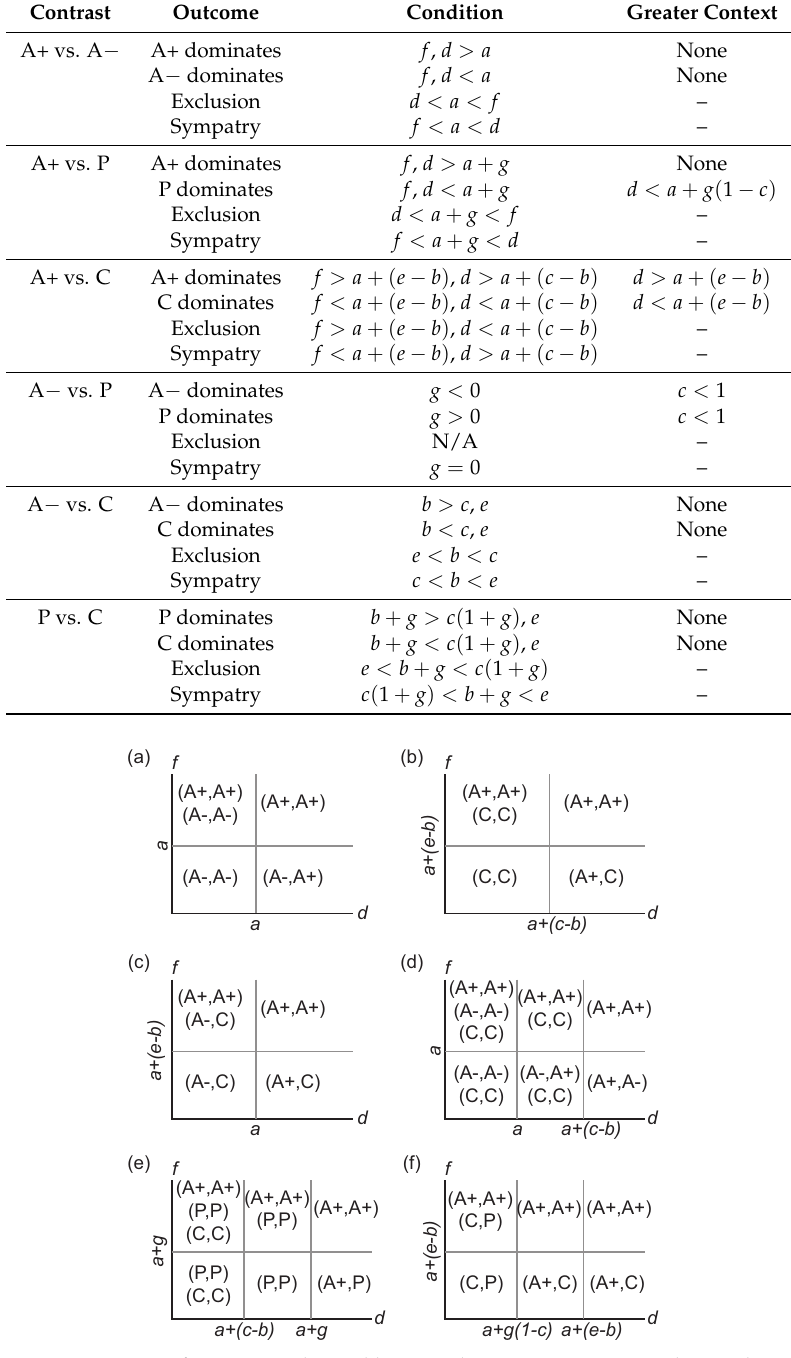
Figure 1. Parametric regions for pure Nash equilibria. Each parametric region admits a limited number of pure Nash equilibria. Panels ( a – d ) show the equilibria for games with strategies A − , A+, and C, while ( e , f ) use A+, C, and P. ( a ) b > c , e , cytotoxic cells excluded; ( b ) b < c , e . A − cells excluded;